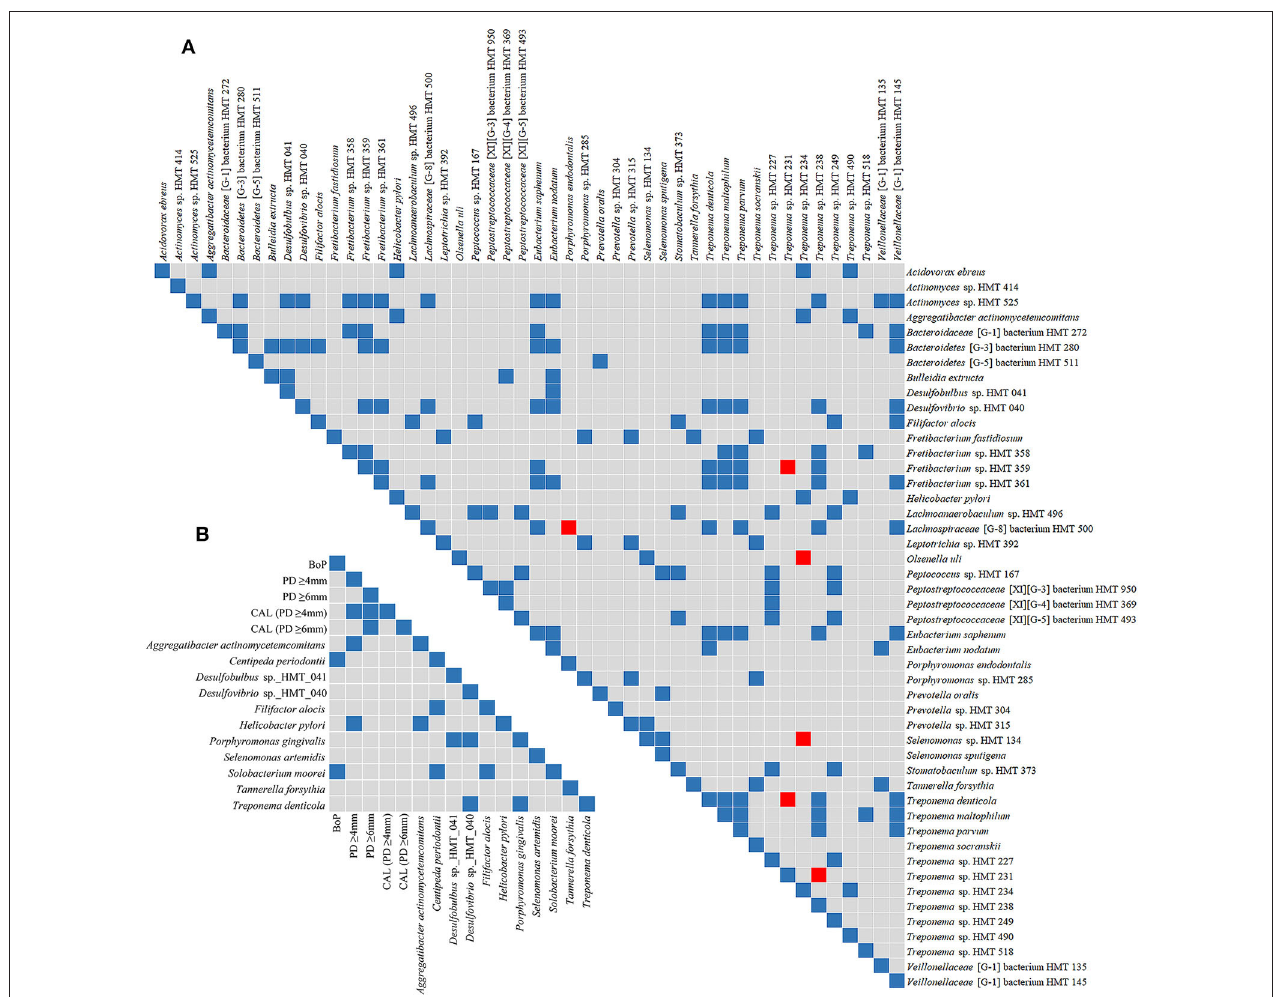
FIGURE 3 | Spearman’s rank correlation matrices. Matrix (A) corresponds to the correlation between species that were more abundant in subgingival affected sites of GC/MIP (SbA_GC/MIP) when compared to subgingival sites of healthy Control. Matrix (B) corresponds to the correlation between the abundance of sulfidogenic bacteria in SbA_GC/MIP and periodontal clinical parameters. Blue squares indicate positive correlations ( R ≥ 0.75, p < 0.05) and red squares indicate negative correlations (R ≤ − 0.75, p <